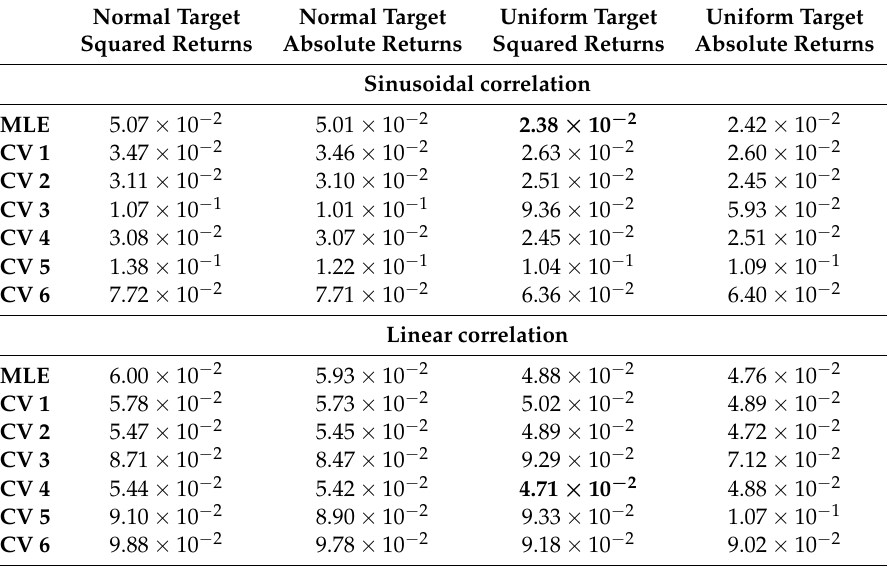
Table 2. Model Selection on multivariate normal returns with specified correlation, 1000 iterations. Table entries are the MSE between ρ t | t − s and ˆ ρ t | t − s . Smallest MSE is presented in bold